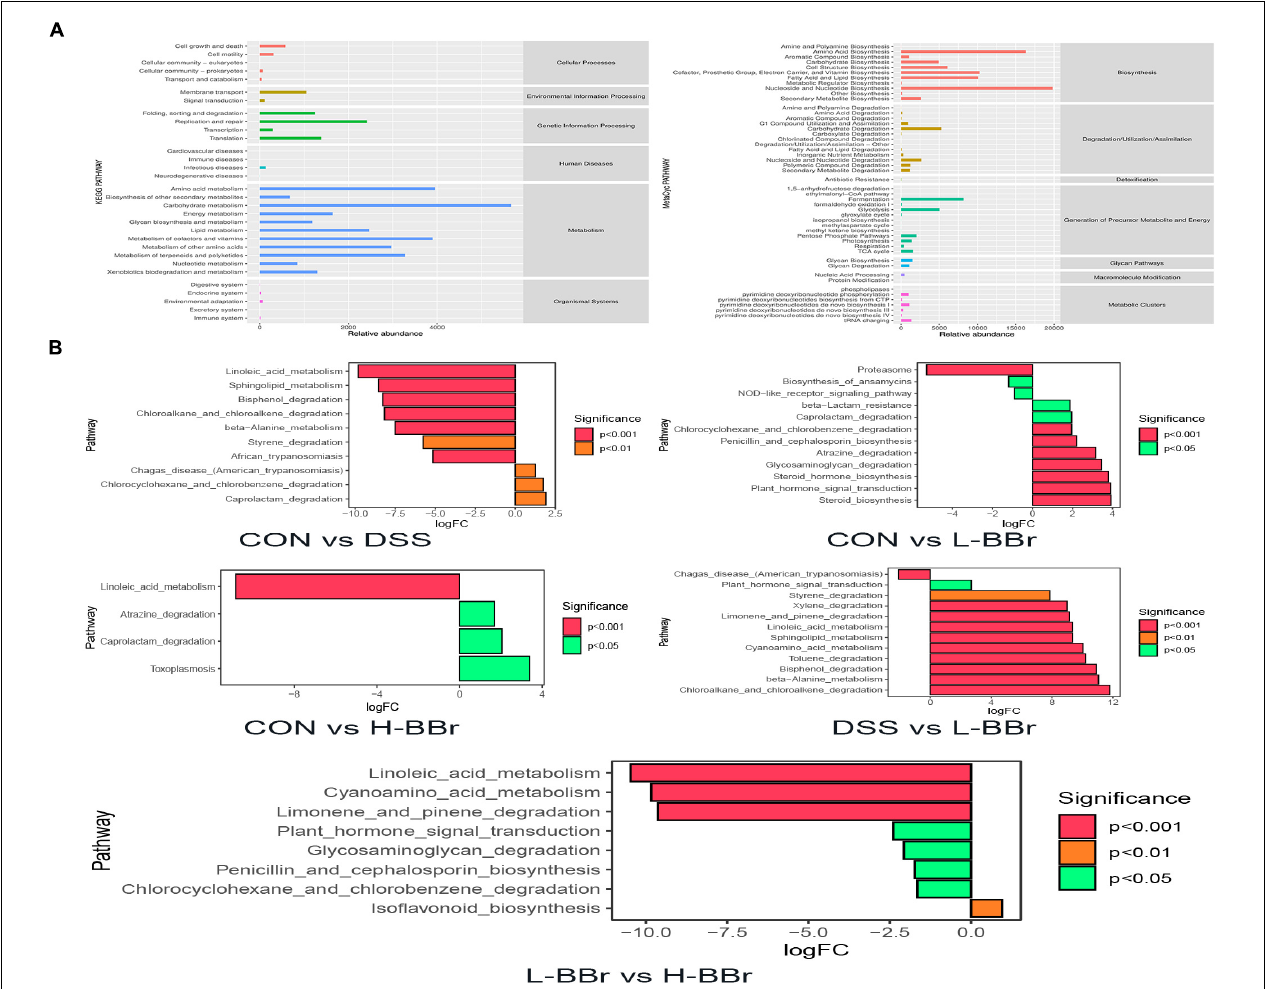
FIGURE 5 | Potential biomarkers and correlation analysis. (A) The KEGG (left) and MetaCyc (right) functional pathway abundance map. The X -axis stands for relative abundance, and Y -axis represents function class. (B) The X -axis represents logFC[log2(fold change)], the positive value represents up-regulation of group (B) relative to group (A) the negative value is down-regulation, Y -axis stands for function